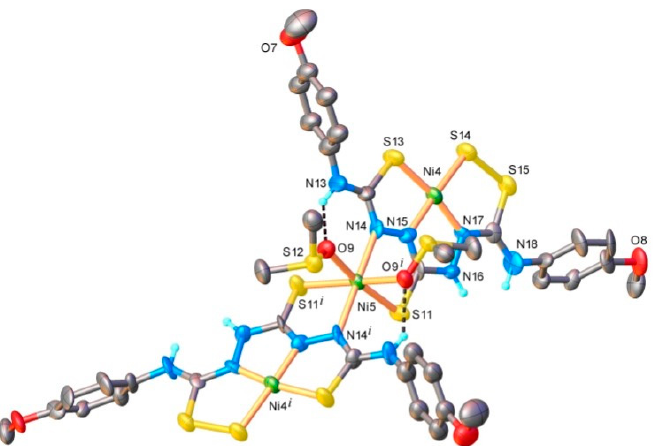
Figure 2. X-ray molecular structure of Ni 3 L 2 with selected atom labelling and thermal ellipsoids at 40% level. Non-relevant H-atoms are omitted for clarity. Symmetry code: I ) 1) 2 − x , y , 1.5 − z . Selected bonds (Å) and angles (°): Ni4-S13 2.133(3), Ni4-S14 2.145(3), Ni4-N15 1.843(8), Ni4-N17 1.786(9), Ni5-